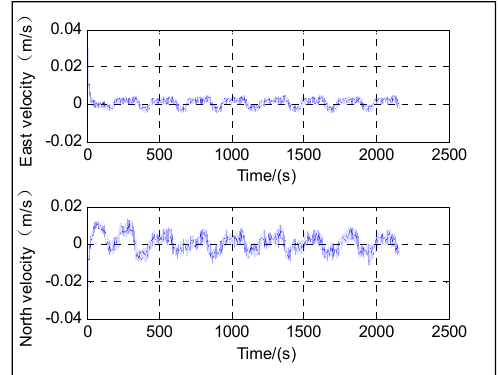
Figure 12. East and north velocities.